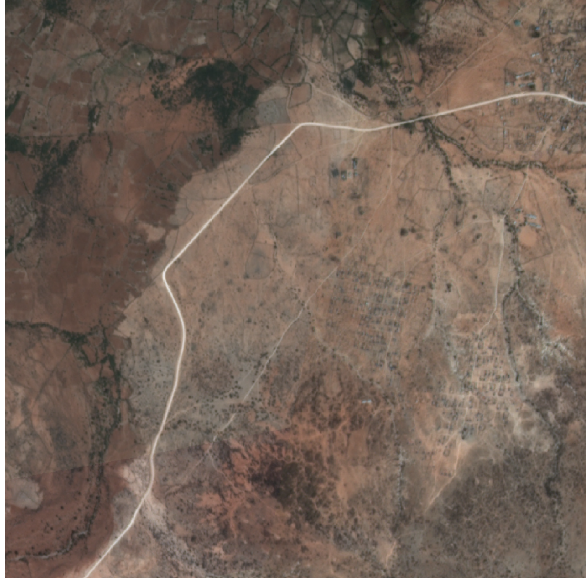
Figure 2. Sample of a rendered composite